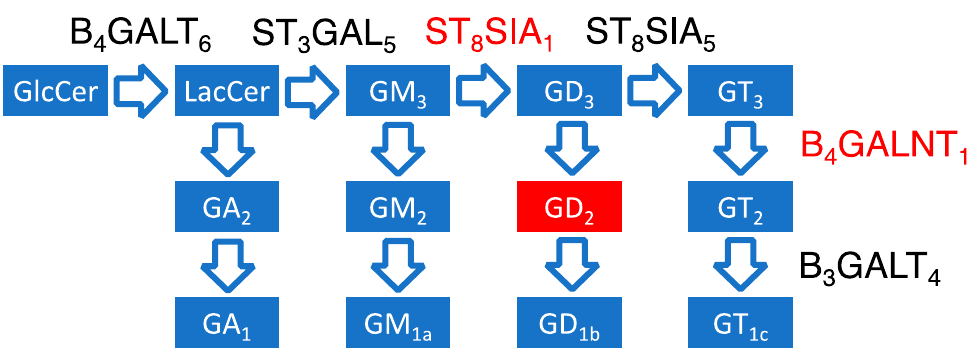
Figure 2. Representation of the ganglioside biosynthesis pathway and potential roles of galactosyl and sialyl transferase enzymes in GD2 synthesis. GlcCer—glucosylceramide, B4GALT6—LacCer synthase, ST3GAL5—GM3 synthase, ST8SIA1—GD3 synthase, ST8SIA5—GT3 synthase, B4GALNT1—GD2 synthase, B3GALT4—GD1b synthase. The most GD2-proximal